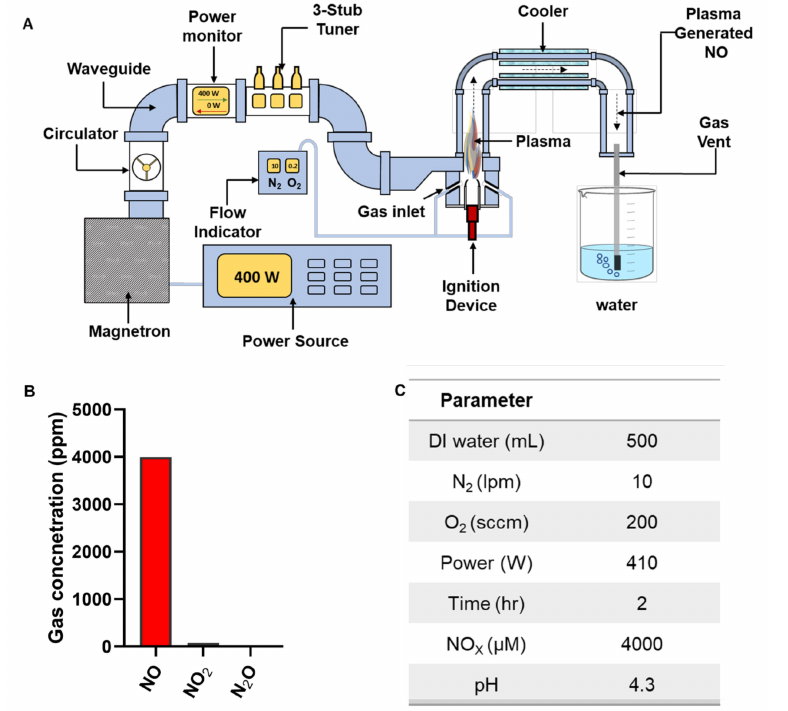
Figure 2. Treatment with PG-NOW. ( A ) Schematic representation of the generation of PG-NOW using gaseous NO by the microwave plasma system, ( B ) summary of the gaseous species’ compo- sition concentration of the microwave plasma, as mentioned in our previous publication [10], and ( C ) parameters for generation of high NOx from gaseous NO exposed to DI water, as indicated and mentioned in our previous publication